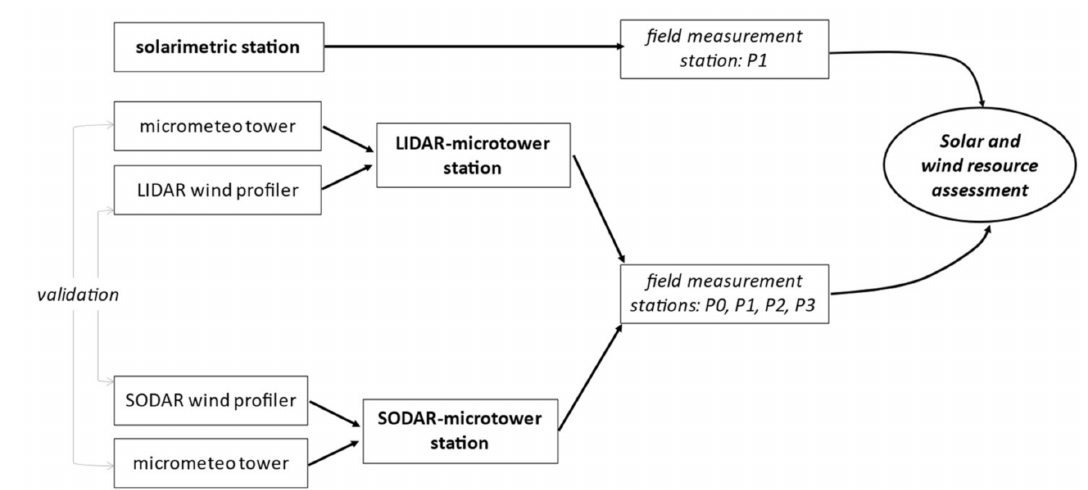
Figure 3. Flowchart of EOSOLAR instruments and methods employed to obtain the necessary information for solar and wind resource